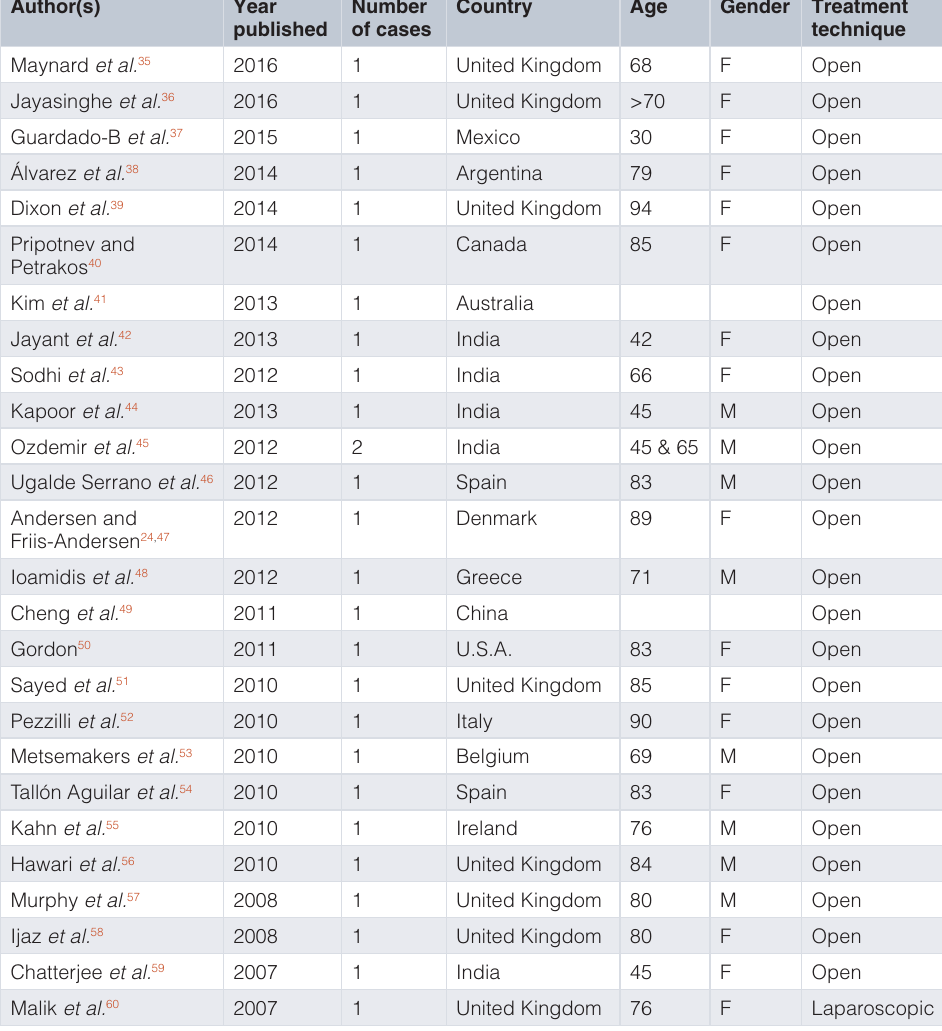
Table 1. Publications within the last 10 years concerning cholecystocutaneous